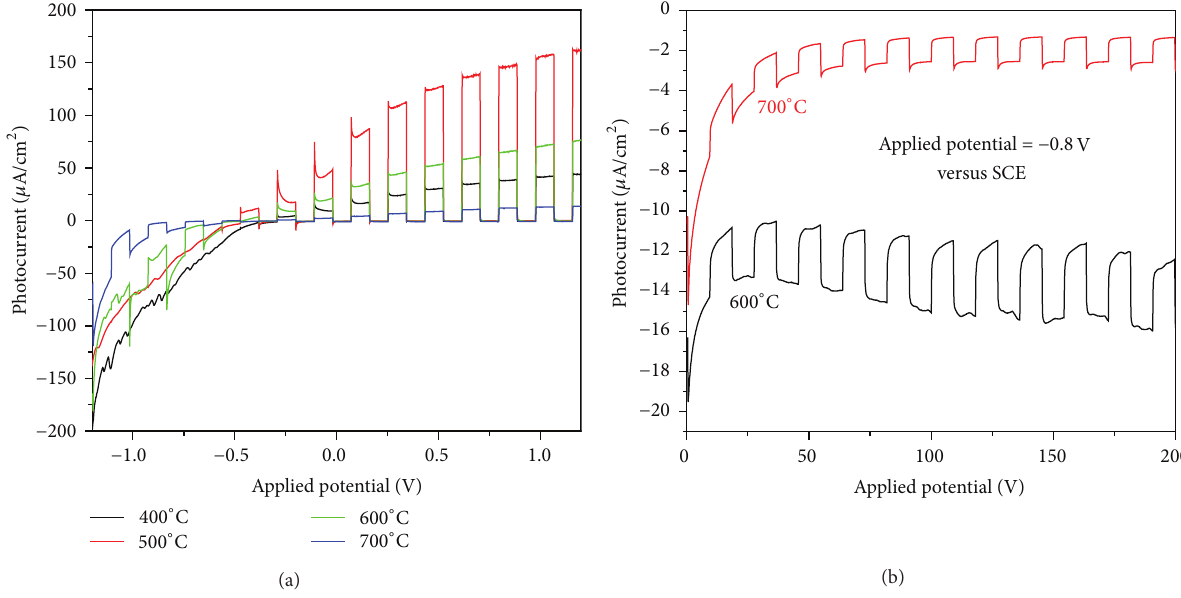
Figure 6: (a) The current-potential curves in 0.5 M Na 2 SO 4 aqueous solution under simulated solar light for TiO 2 formed by Ti ion implantation and subsequent annealing at 400, 500, 600, and 700 ∘ C. (b) The i-t curve annealed at 600 and 700 ∘ C.